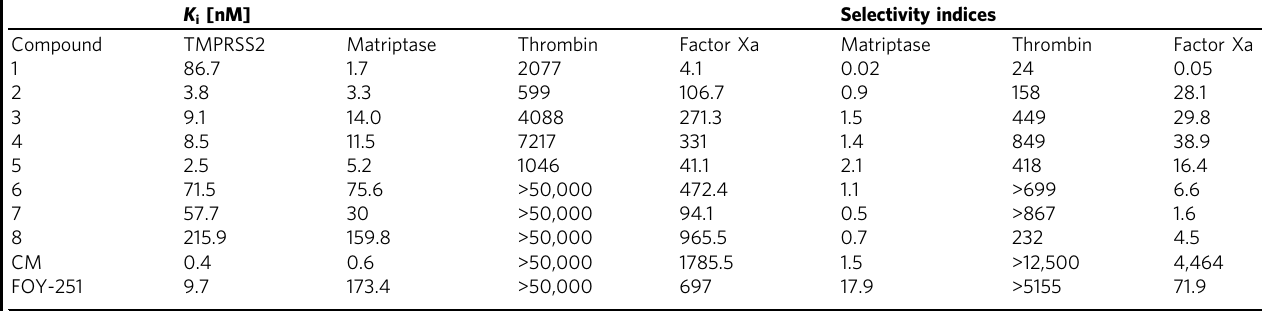
Selectivity indices represent the quotient of K i values of matriptase, thrombin, and factor Xa by the K i value of